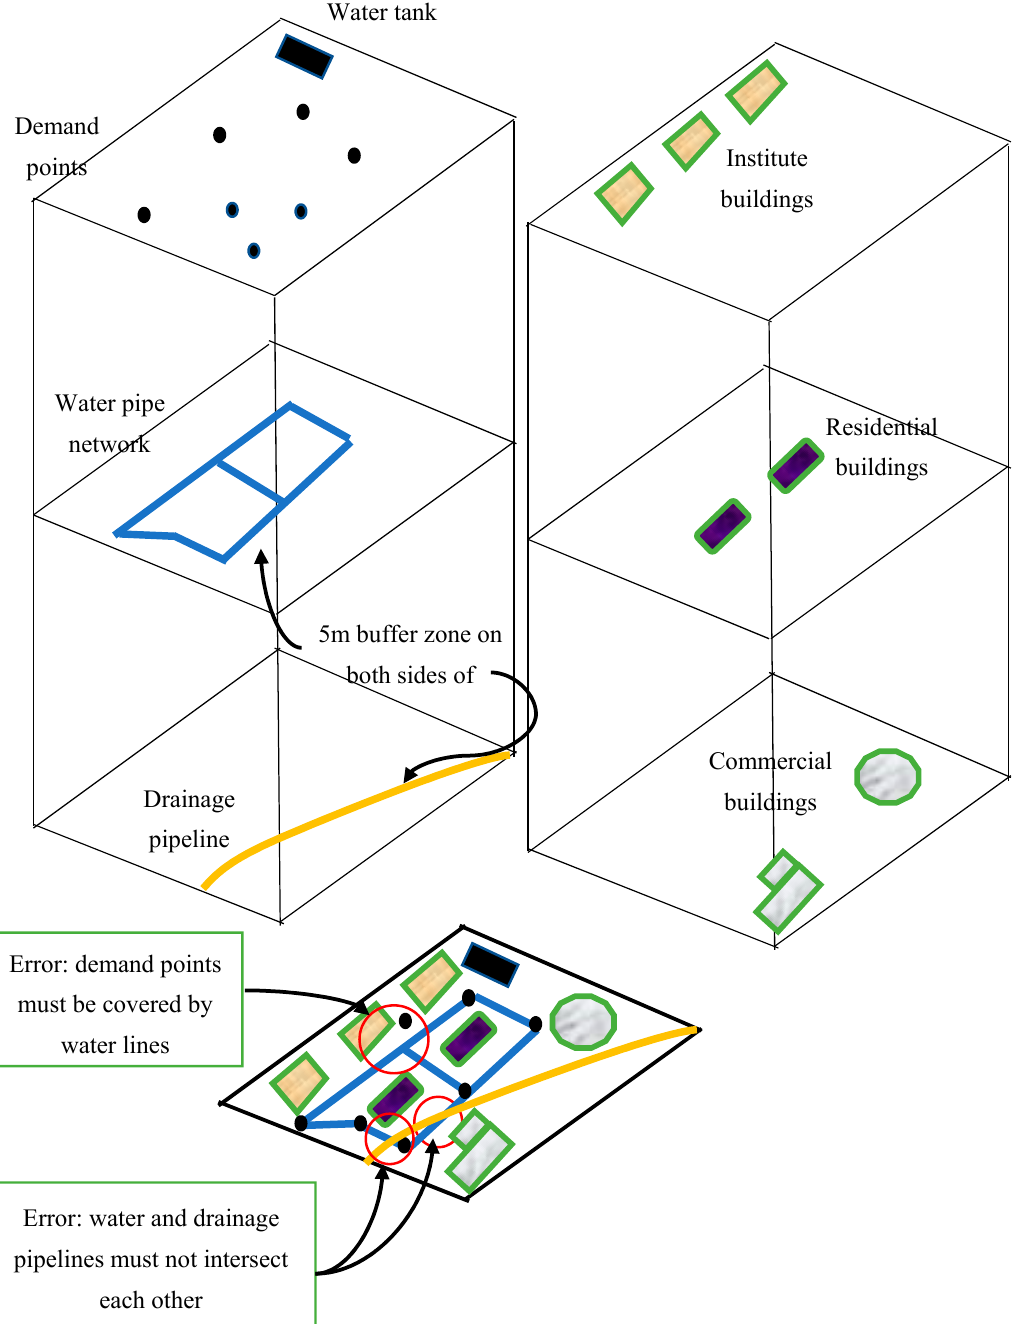
Figure 8. Schematic description of the spatial relationships among points, lines, and areas (PLAs).